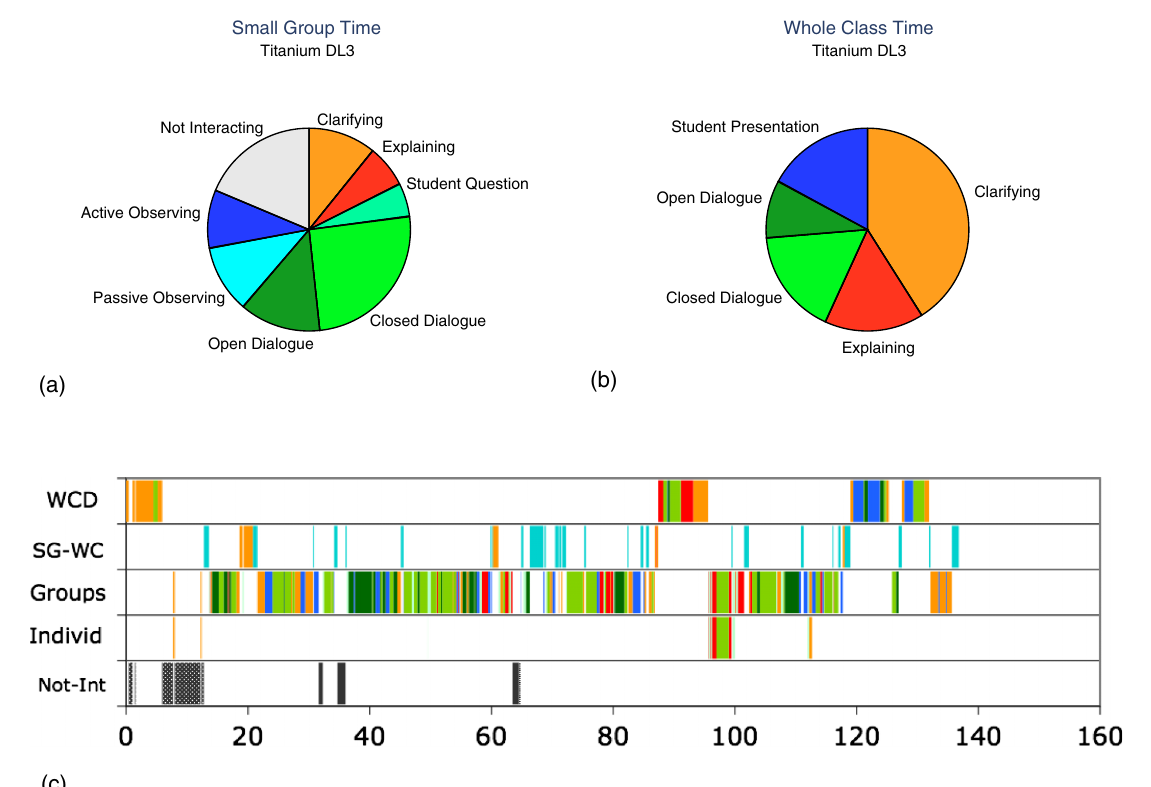
FIG. 1 (color online). Instructor Titanium (DL 3, CLASP B). Small group time breakdown (a), whole class breakdown (b), and